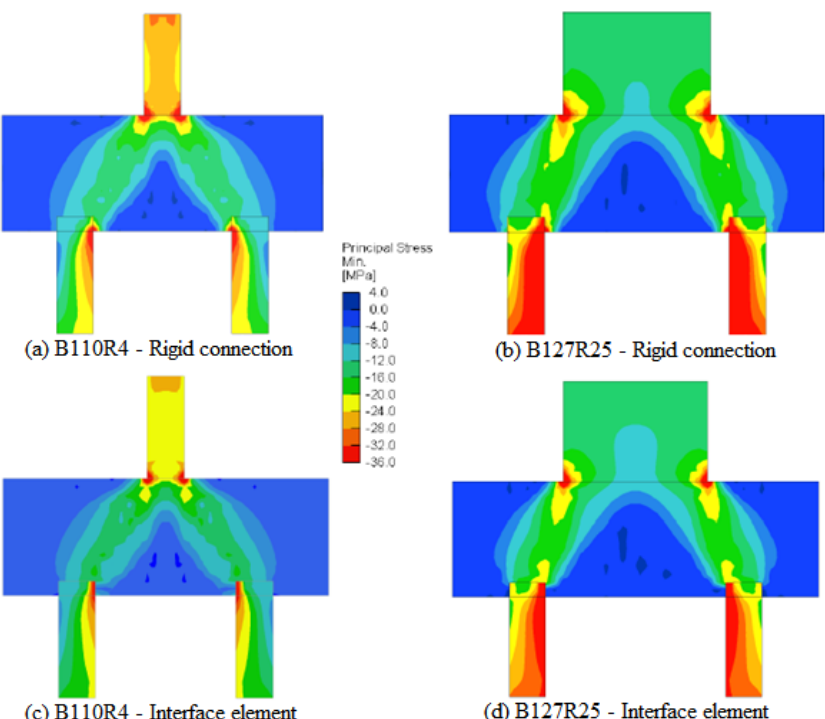
Figure 9. Influence of pile cap-pile connection on stress flow in numerical models (a) B110R4LR, (b) B127R2.5LR, (c) B110R4LI and